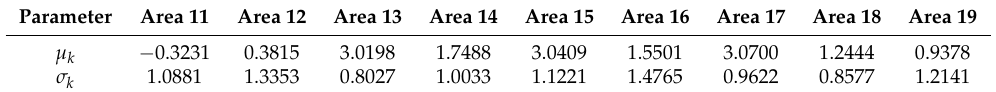
Table 14. Values of the parameters µ k and σ k estimated from the log data in Example 5, part II.